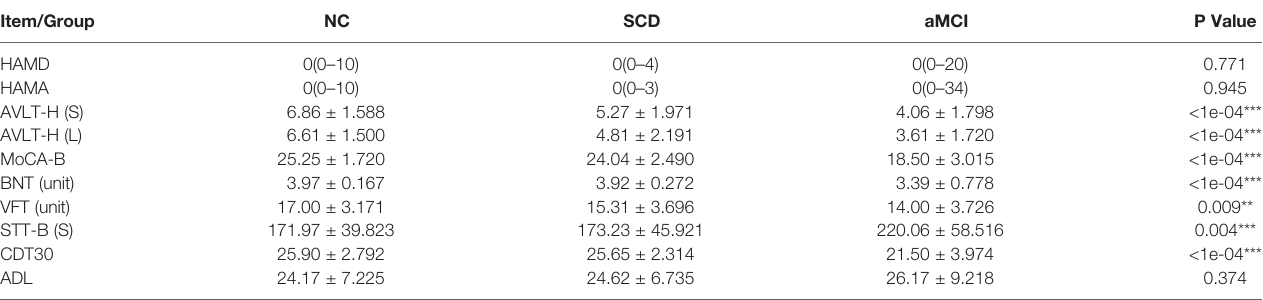
TABLE 2 | Differences in cognitive scale items between the three